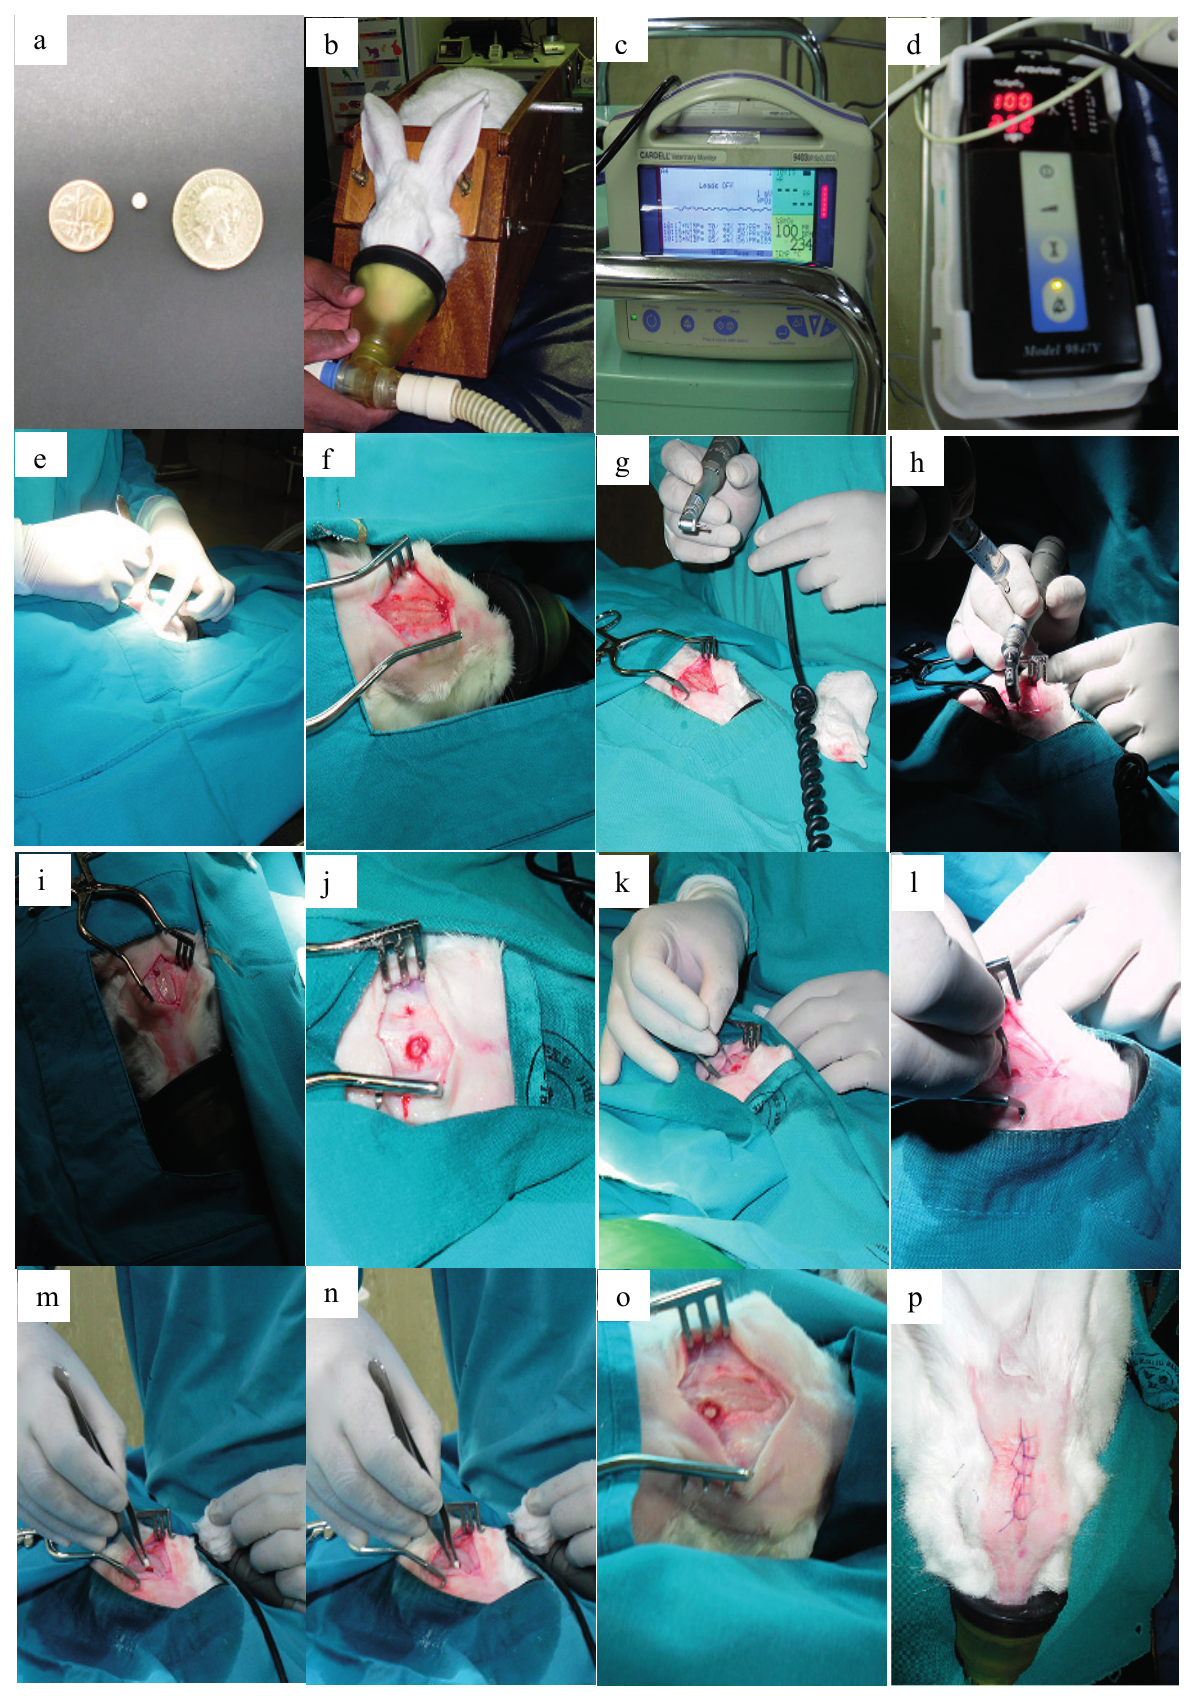
Figure 18. Implantation of the NCPM into the frontal lobe of the New Zealand White Rabbit brain (Time frame = 15 min). ( a ) Relative size of the implanted NCPM when compared to